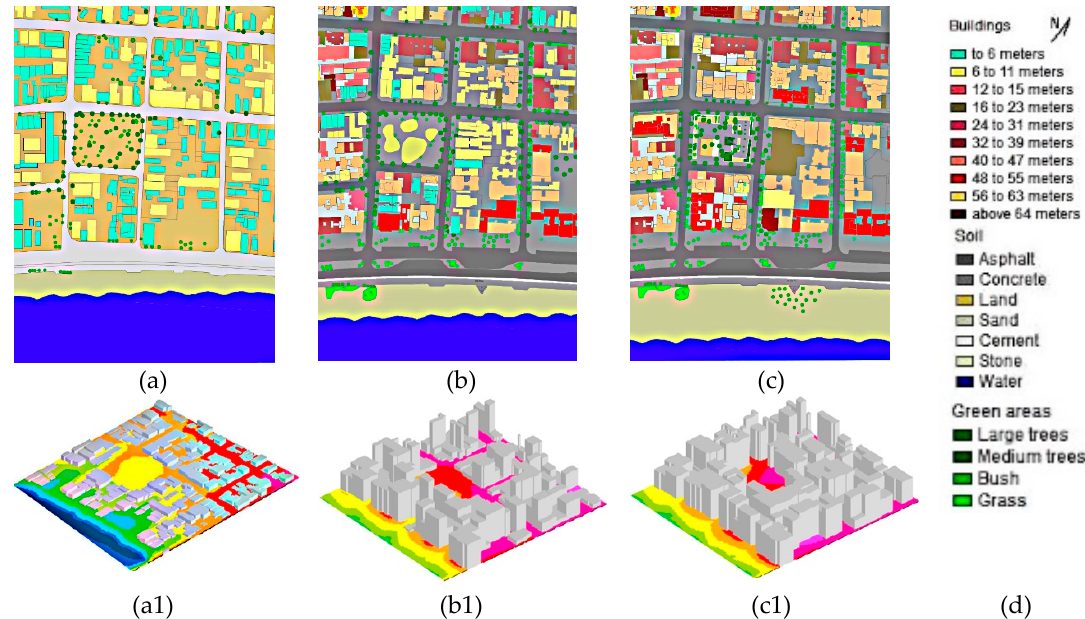
Figure 2. Description of the input file area for ENVI-met: ( a ; a1 ) Sprawl Morphology (urban form data: 1930); ( b ; b1 ) Medium Morphology (urban form data: 1950); ( c ; c1 ) Density Morphology (urban form data: 2018).The legends indicate the building heights and soil coverage ( d ).